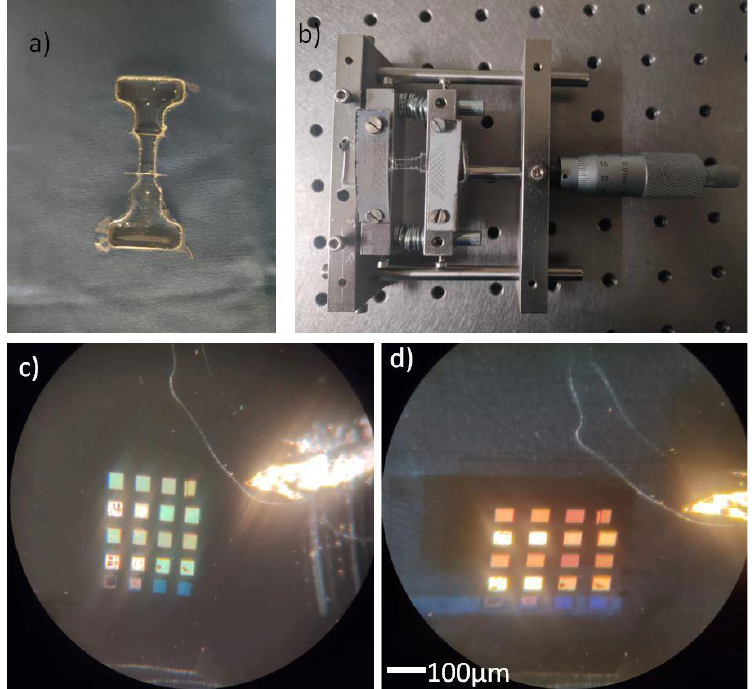
Figure 5. ( a ) photo of the PDMS mold; ( b ) homemade stretching equipment; ( c ) dark-field micro- scope image of unstretched flexible 2D grating; ( d ) dark-field microscope image of flexible 2D grat- ing with 50% stretch length. 50% stretch